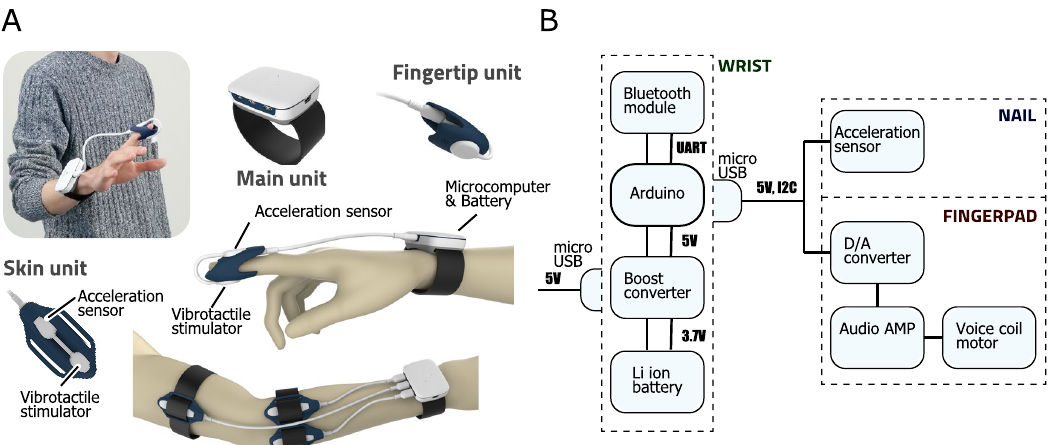
Figure 6. Proposed wearable light touch (WLT) device. ( A ) Image and hardware composition of the WLT device in experiment 3. The main unit with a microcomputer and Li ion battery can be worn on the wrist. The acceleration sensor and vibrotactile stimulator are attached to the fingernail and fingerpad, respectively, and the device supports fingertip mode and body mode for acceleration monitoring and provision of stimulation. ( B ) Device circuit components. The device can be charged via USB and communicate with the computer via Bluetooth. The stimulation signals generated are sent to the voice coil motor via a D/A converter and amplifier.